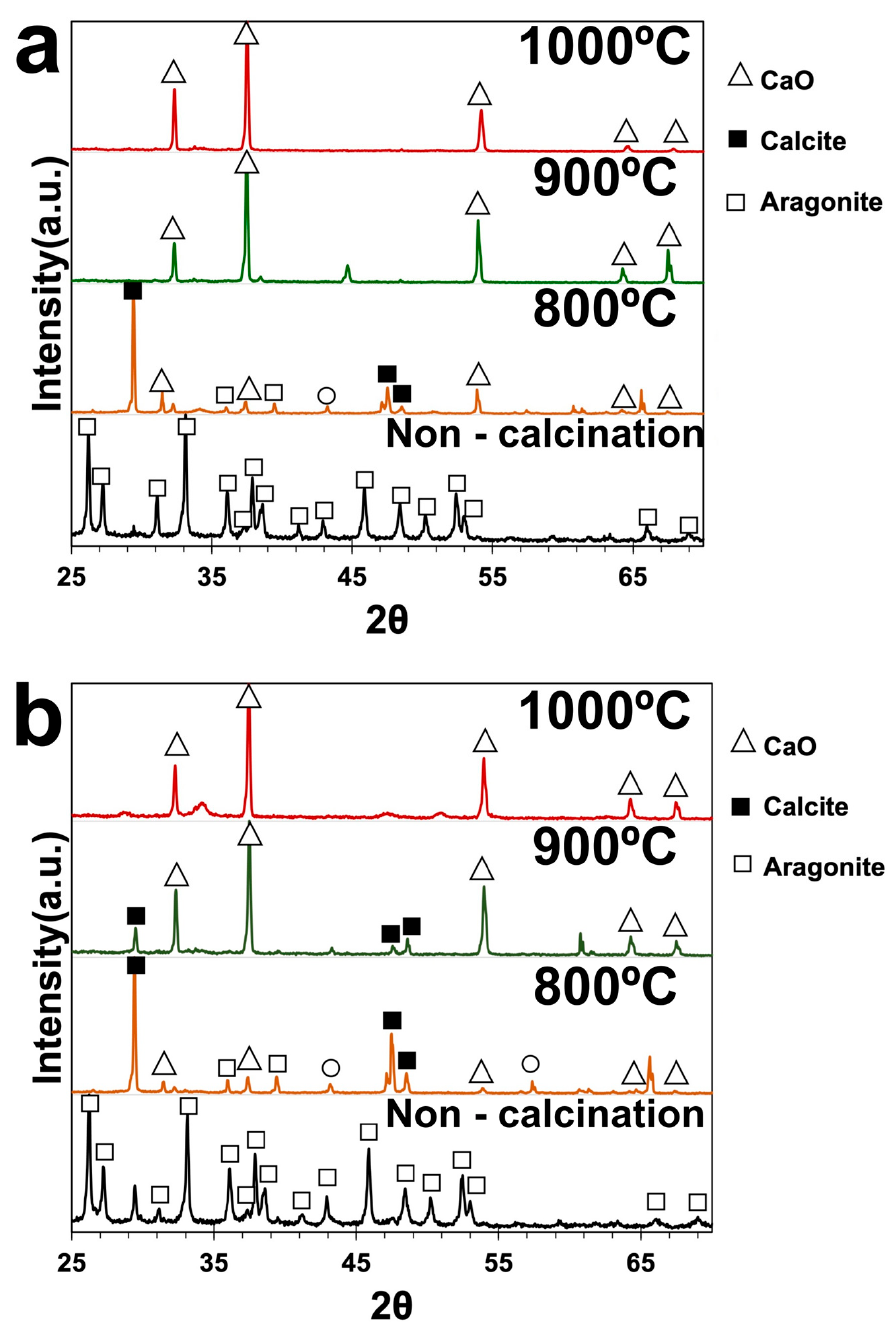
Figure 4. The XRD spectrum of ( a ) green mussel shells and ( b ) mixed shell powder.